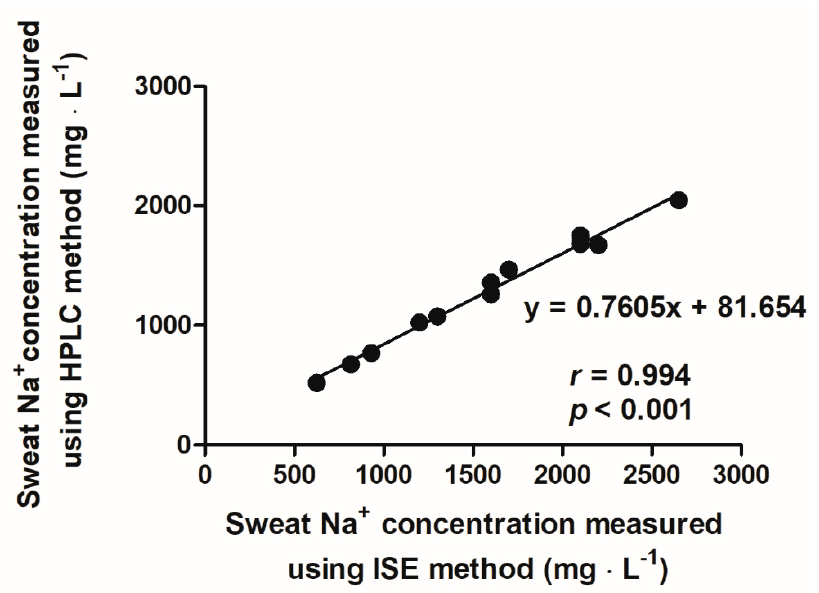
Figure 3. Relationship between sweat Na + concentration measured by ion-selective electrode (ISE) and high-performance liquid chromatography (HPLC) methods.